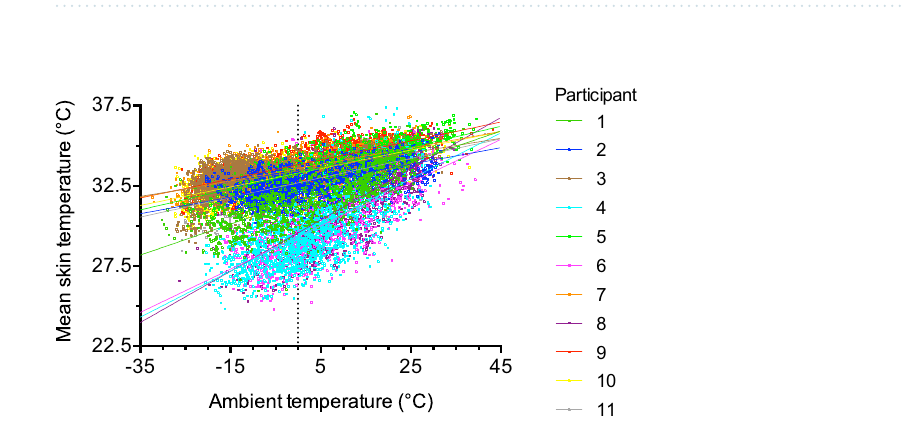
Figure 2. The relationship between the participant’s ambient temperature and mean skin temperature during the day (07:00–19:00) of the whole period. One subject’s data were excluded due to non-wear of the clothing temperature sensor, therefore n = 11 (8 males and 3 females). Participant numbers 4, 6, and 8 are females.